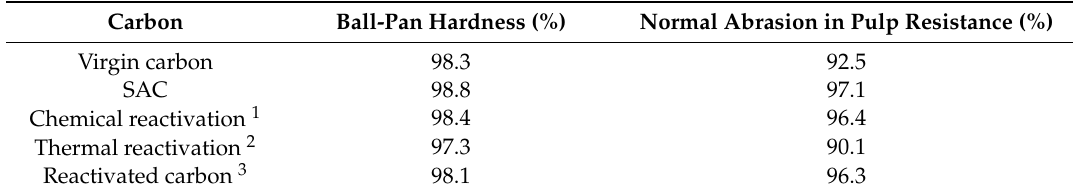
Table 4. Ball-pan hardness (%) and normal abrasion in pulp resisitance (%) of virgin carbon, SAC, chemically reactivated carbon, thermally reactivated carbon, and chemical-thermally reactivated carbon. Carbon Ball-Pan Hardness (%) Normal Abrasion in Pulp Resistance (%) Virgin carbon